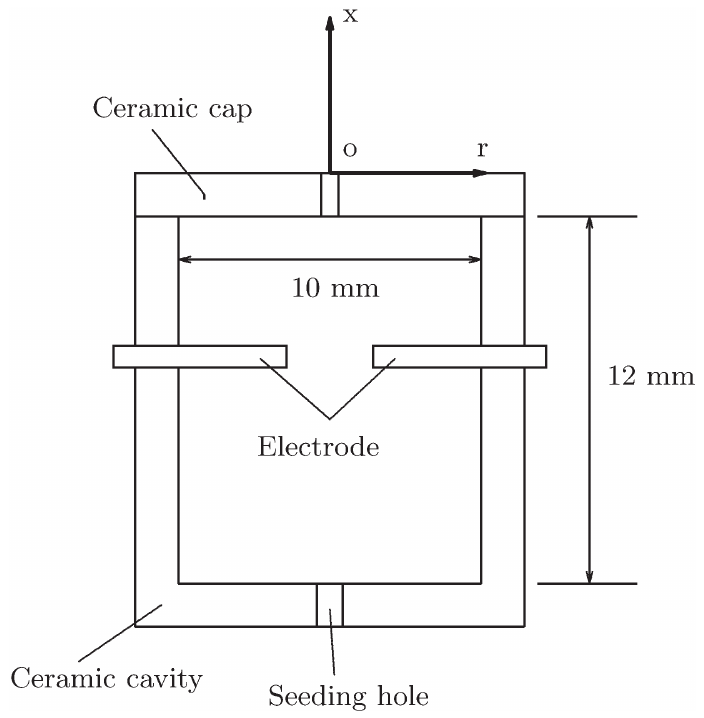
Figure 26. Large cavity model.